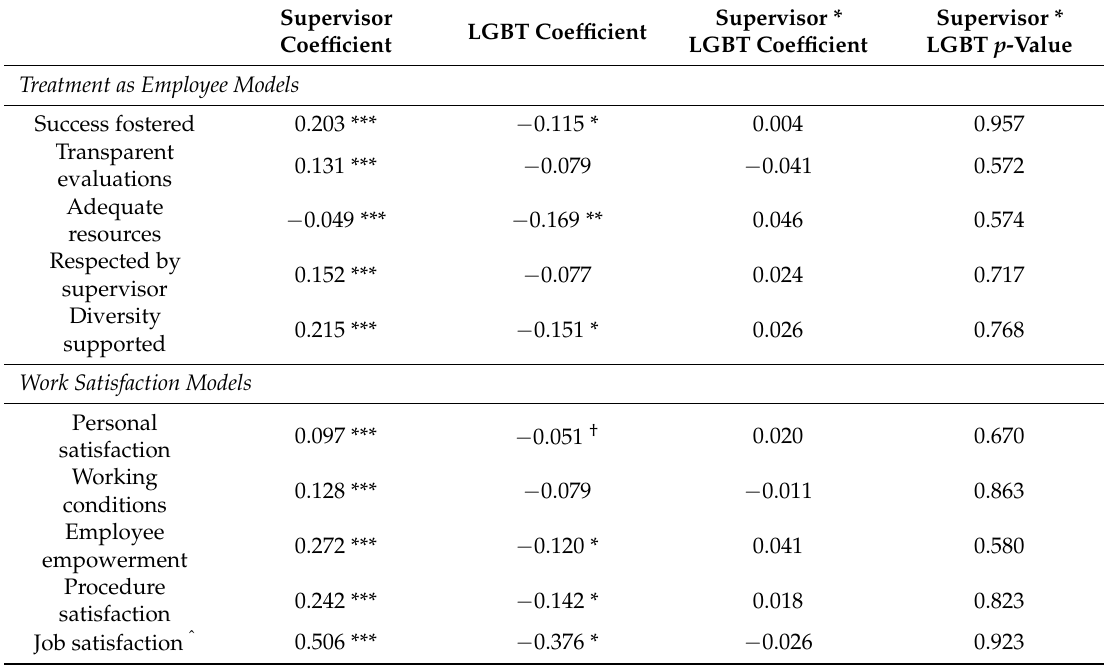
Table 4. OLS and Ordered Logistic Regression Models Predicting Workplace Experience Measures with LGBT X Supervisor Status Interaction Term (N =